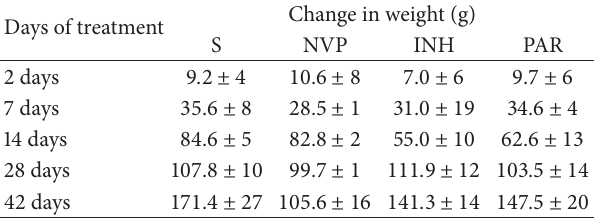
Table 1: Change in body weight (mean ± SD) during treatment of the rats with NVP, INH, and PAR over the study